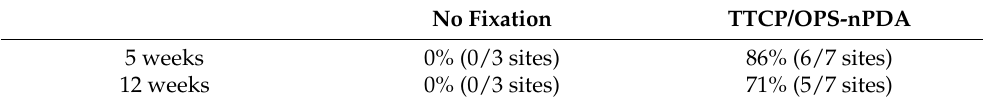
Table 1. Results of clinical assessment of the autograft fixation with success. No